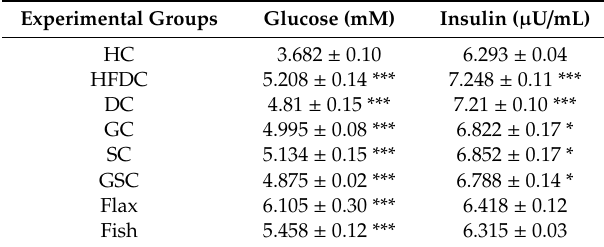
Table 6. Serum glucose and insulin for HOMA-IR assessment.